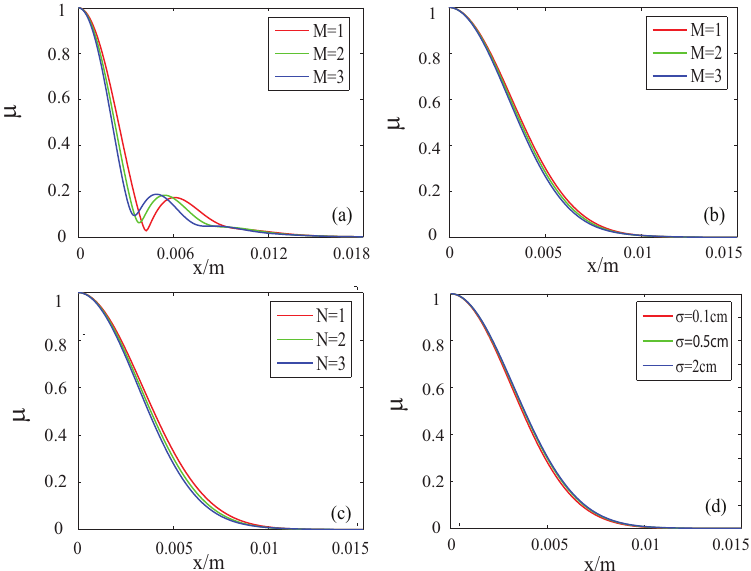
Figure 8. Spectral degree of coherence of the OAHGSM vortex beam passing through anisotropic oceanic turbulence with different M , N , and δ at z = 300 m ( a ), z = 1200 m ( b ), z = 1200 m ( c ), and z = 1200 m ( d